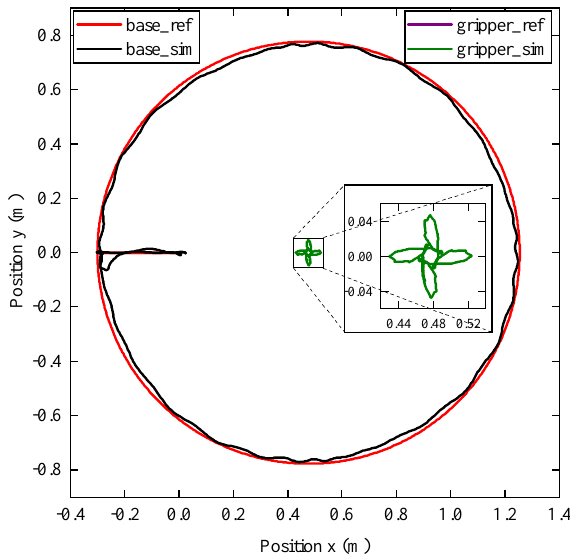
Figure 8. Comparison between planned trajectories and actual trajectories. The large circle represents the base trajectory, and the center of the circle represents the gripper trajectory. The red and black lines represent the offline planned base reference and actual trajectories, respectively. The purple and green lines represent the planned and actual gripper